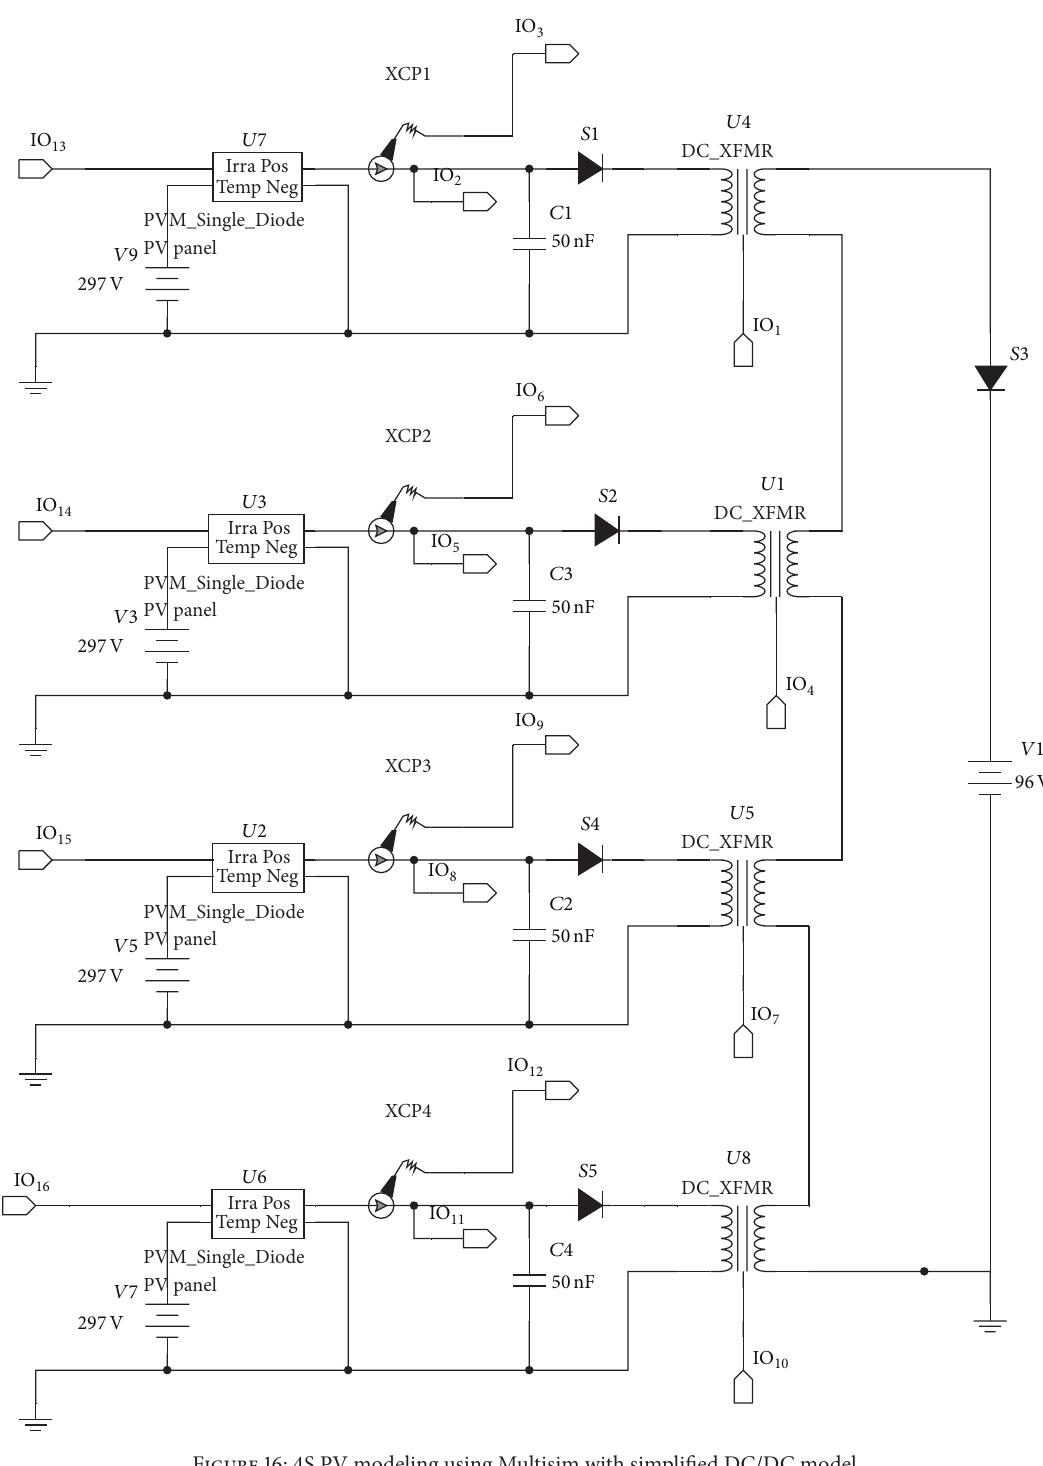
Figure 16: 4S PV modeling using Multisim with simplified DC/DC model.